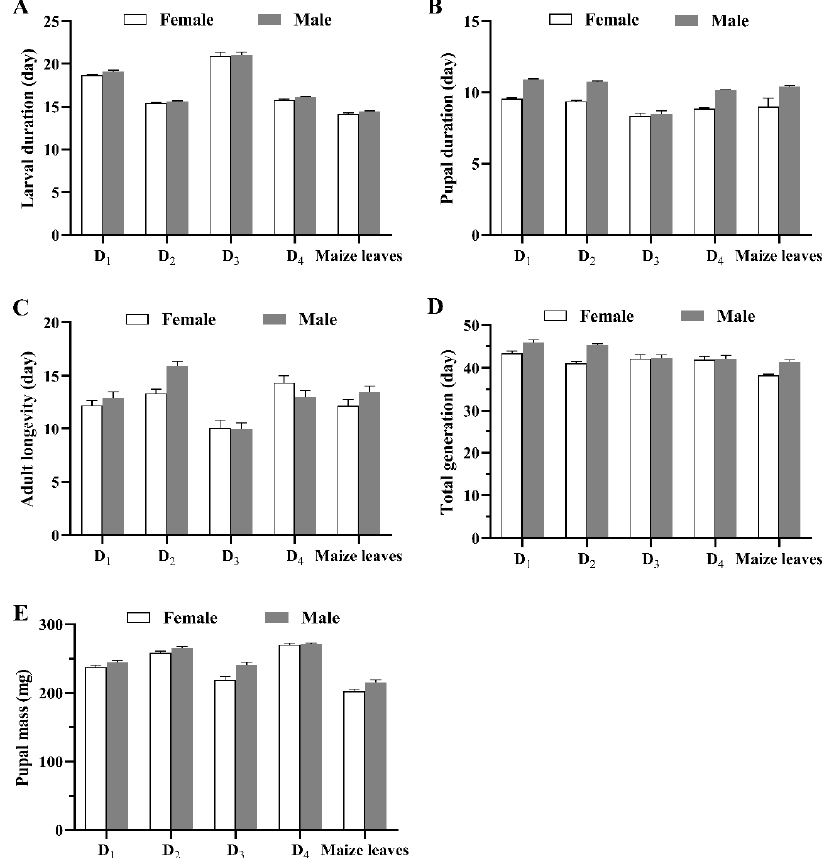
Figure 1. Mean duration ( ± SE) of developmental stages (( A ): larval duration; ( B ): pupal duration; ( C ): adult longevity; ( D ): total longevity) and pupal mass ( E ) of female and male Spodoptera frugiperda individuals fed different diets.